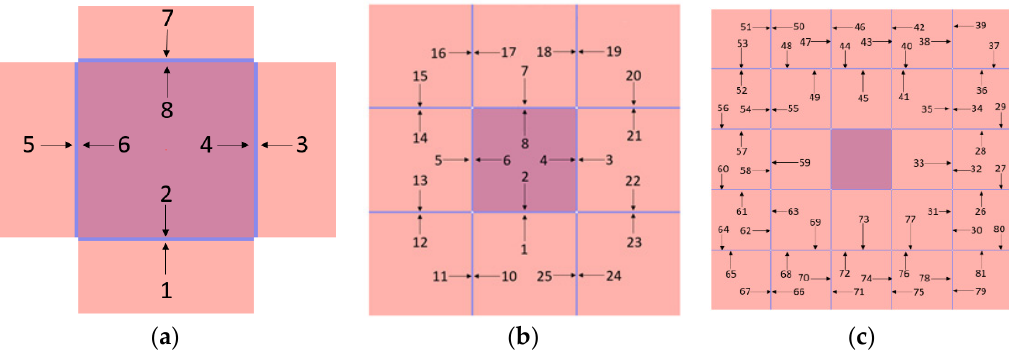
Figure 5. ( a ) The receiver positions in case 1 and 4; ( b ) the receiver positions in Case 2 and 5; ( c ) the receiver positions in Case 3.